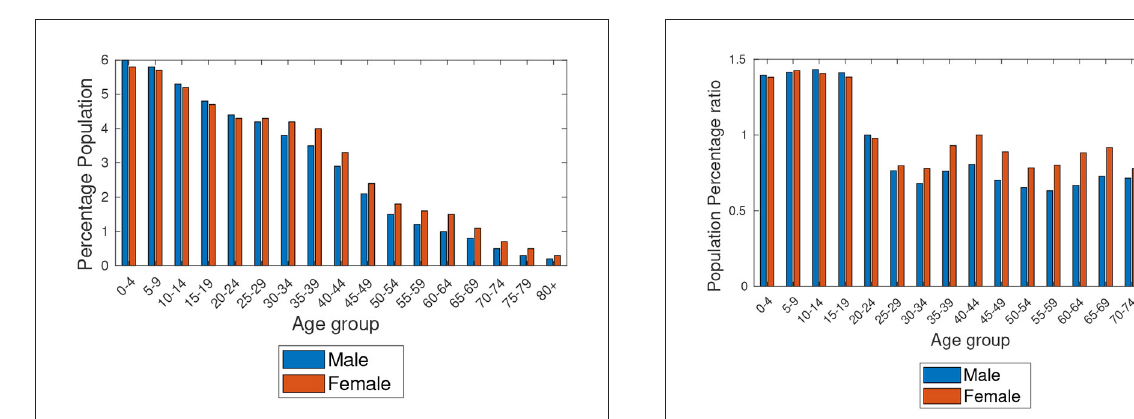
FIGURE3 Age structures of the population’s ratio of Botswana and Gauteng—South Africa.